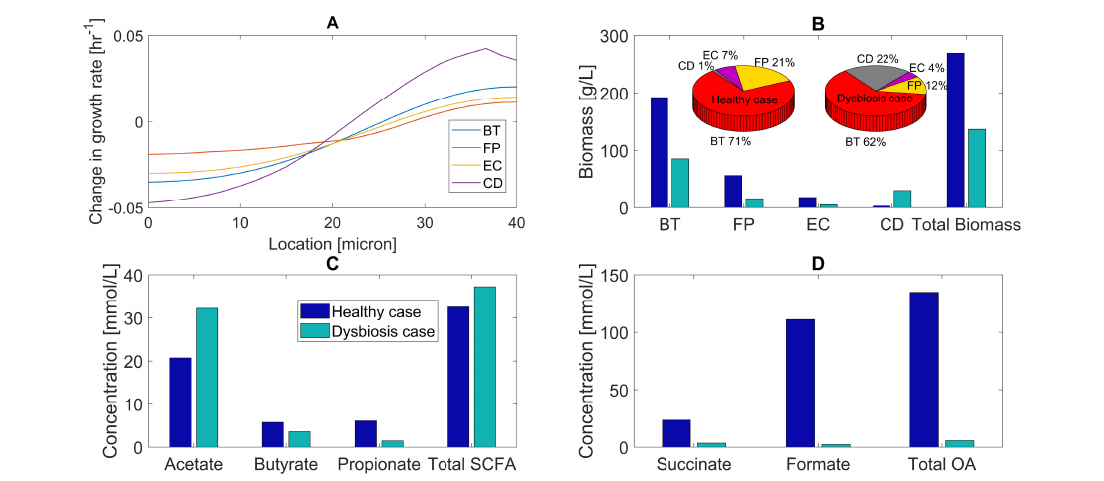
Figure 3. Predicted multispecies biofilm dysbiosis resulting from host–microbiota perturbations in glucose and amino acid concentrations. ( A ) Change in species growth rates across the biofilm plotted as the difference between the growth rates for the healthy and dysbiosis cases. ( B ) Biomass concentrations (bar graphs) and species abundances (pie chart) averaged across the biofilm for healthy and dysbiosis case. ( C ) Acetate, butyrate, propionate, and total SCFA concentrations averaged across the biofilm. ( D ) Succinate, formate, and total OA concentrations averaged across the